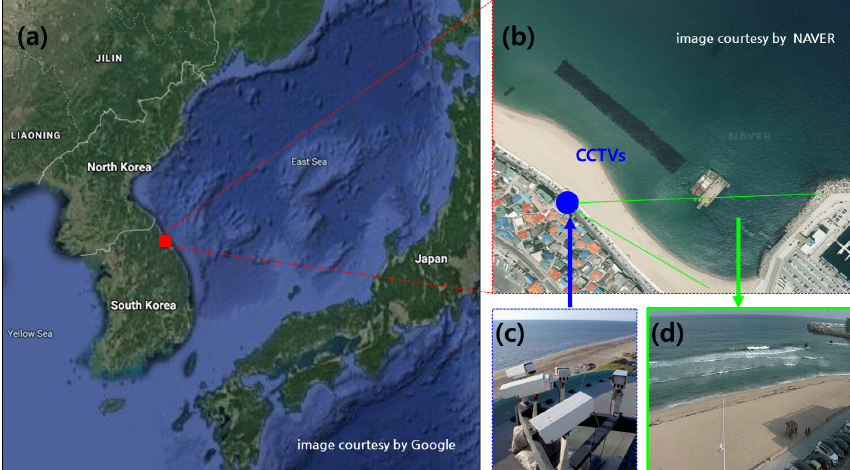
Figure 1. Study area of ( b ) Anmok beach located in ( a ) north-eastern South Korea with ( c ) installed CCTVs location and ( d ) a sample of recorded video